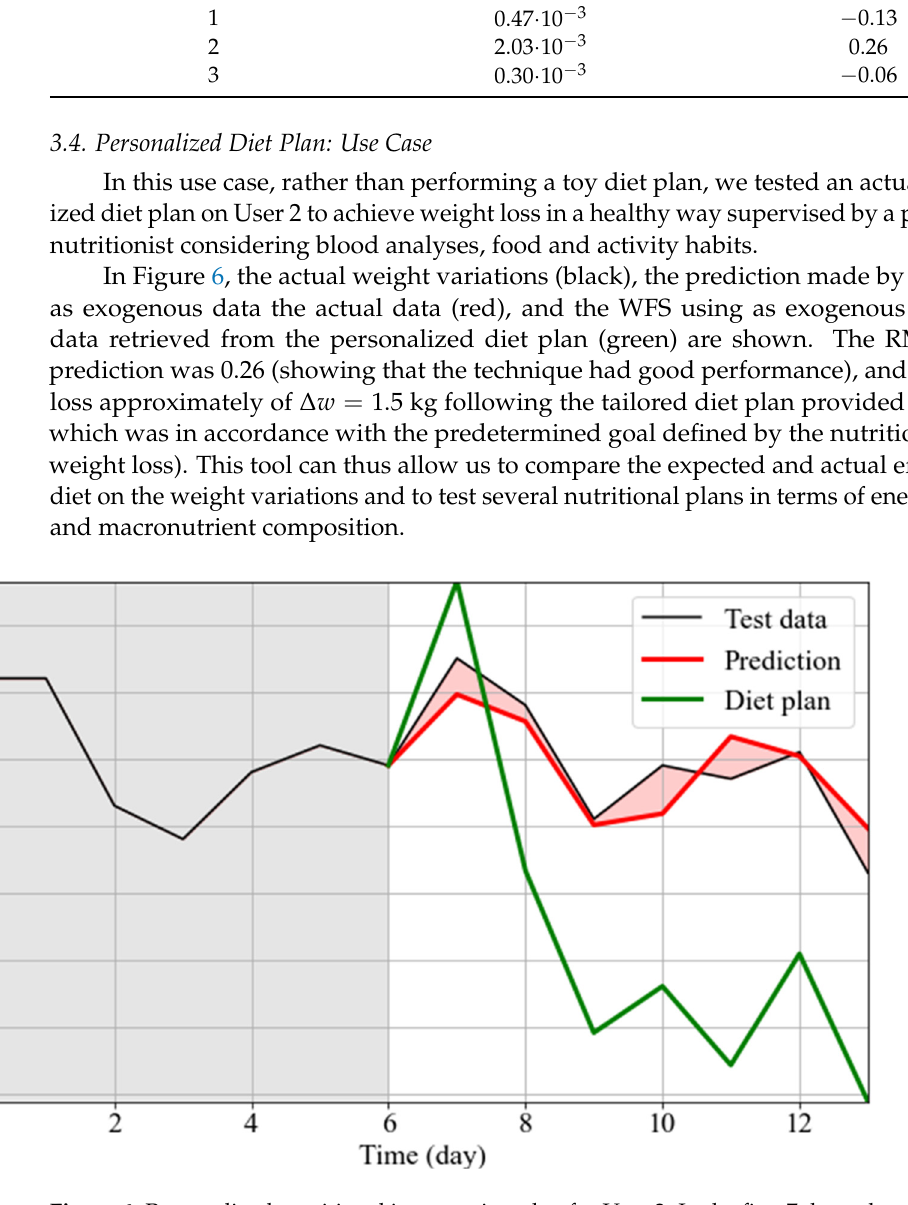
Figure 6. Personalized nutritional intervention plan for User 2. In the first 7 days, the actual weight trend is shown (black line, gray shaded area). Along this trend, WFS for the personalized plan is reported (green line). As a control, WFS when covariates retained the actual values is reported (red line).